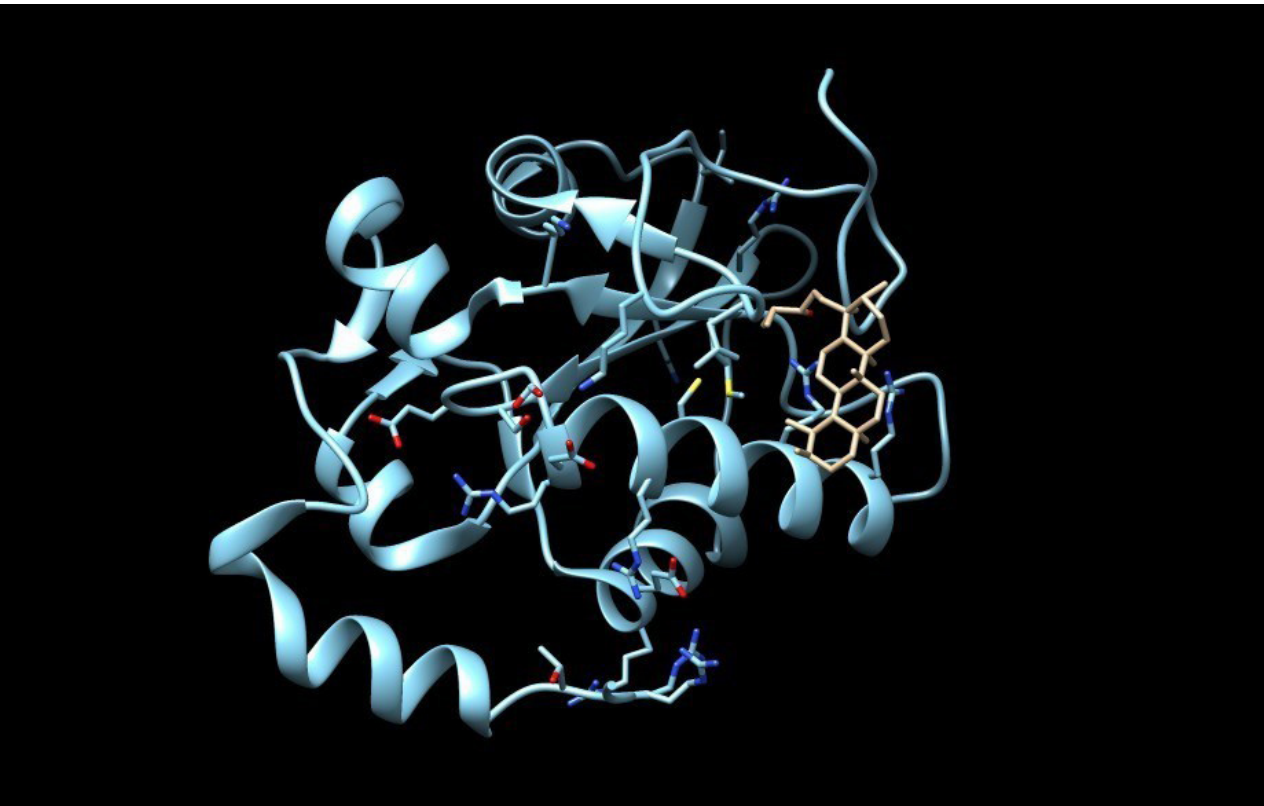
FIGURE 2 - Molecular Docking performed between the tumor target CDC25B and the ligand Alpha-amyrin, whose ligand is the molecule in